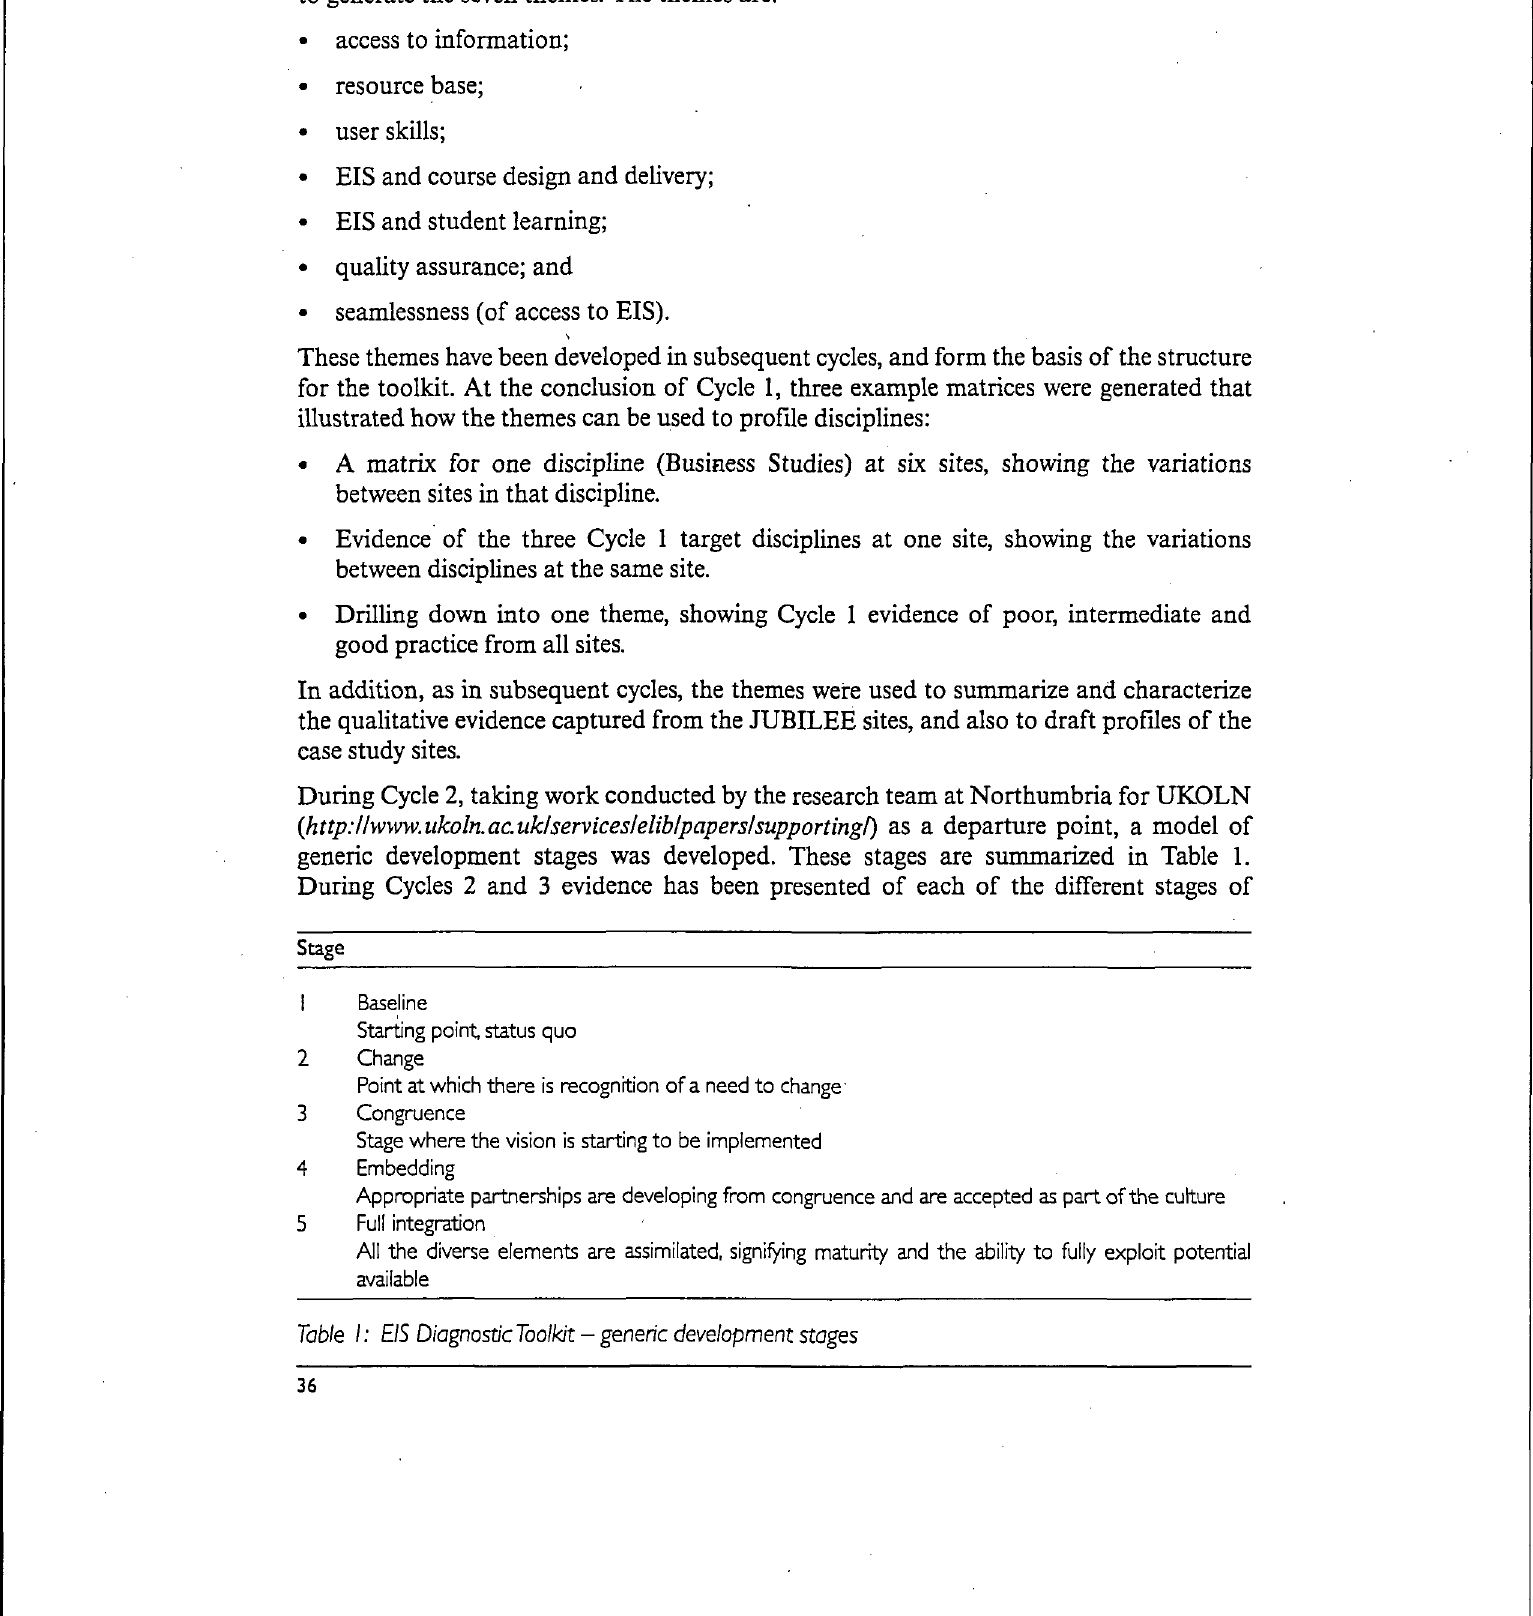
Table I: EIS DiagnosticToolkit - generic development